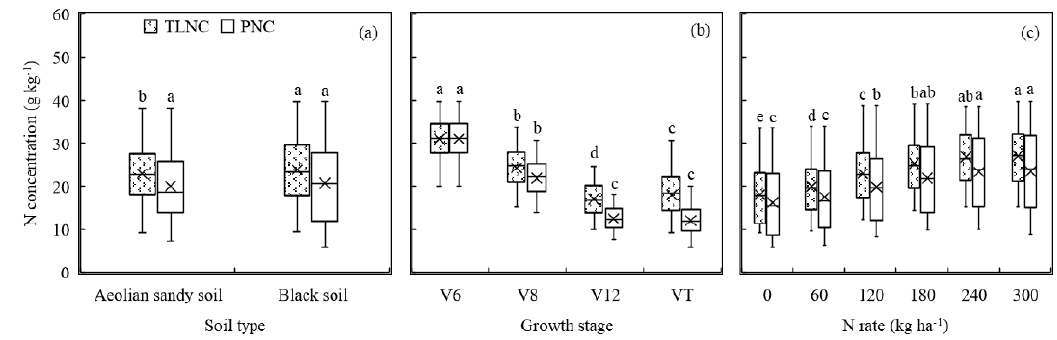
Figure 3. Total leaf N concentration (TLNC) and plant N concentration (PNC) as a ff ected by di ff erent soil types ( a ), growth stages ( b ), and N rates ( c ). The di ff erent letters above the boxes indicate that the TLNC and PNC values di ff ered significantly according to the least significant di ff erence test at p ≤ 0.05.